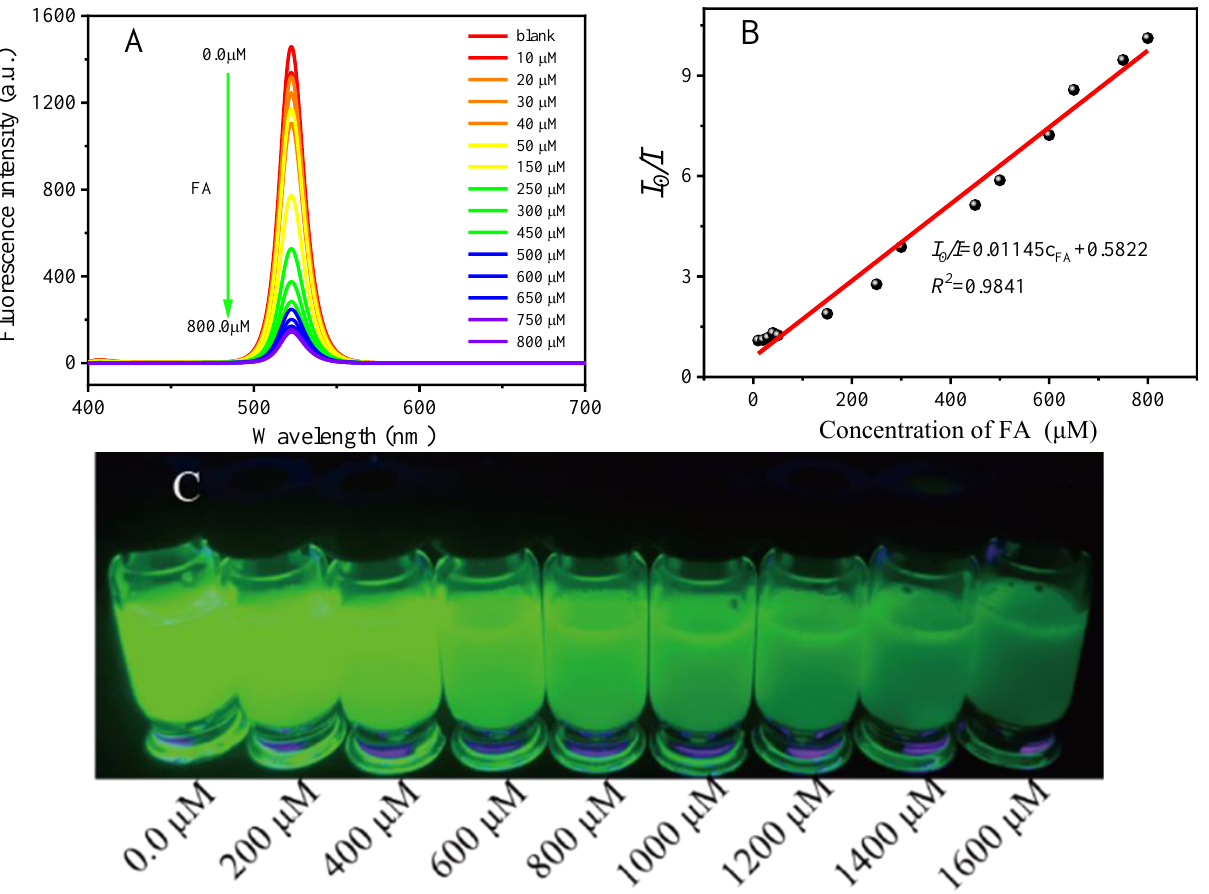
Figure 7. Quantitative detection ( A , B ) and visual detection ( C ) of folate acid by CsPbBr 3 /Cs 4 PbBr 6 PNCs. Fluorescence quenching ratio ( I 0 /I ) ( B ) and fluorescence spectrum ( A ) as a function of FA concentration. Experimental conditions: the concentration of CsPbBr 3 /Cs 4 PbBr 6 PNCs is 0.156 mmol, in terms of Cs atoms, and the concentration of FA is 10 –1600 μM. Reaction temperature: 25 °C, response time: 5 min.